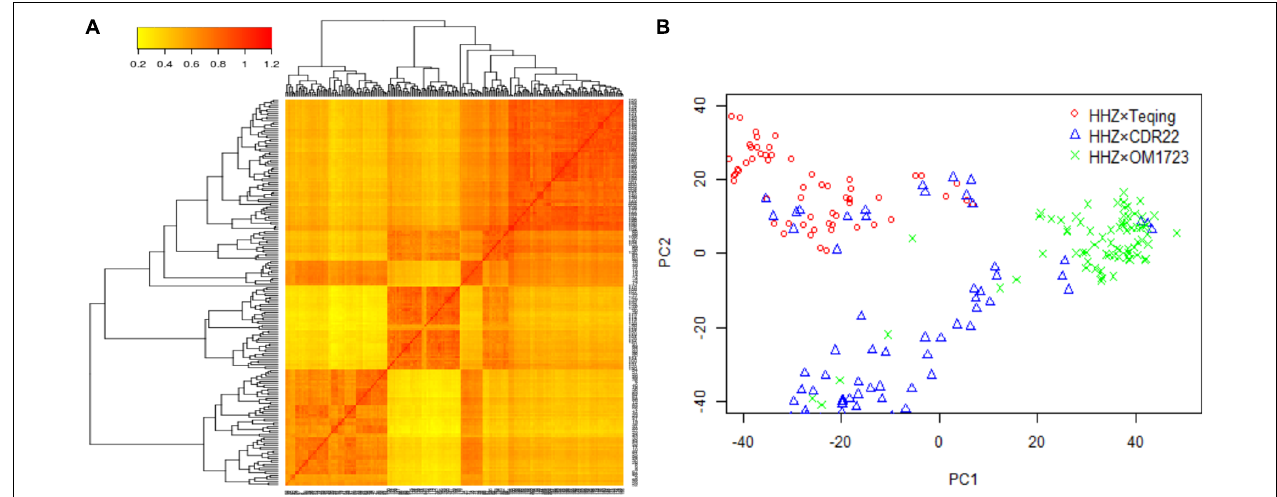
FIGURE 1 | Population structure analysis. (A) Heat map of kinship matrix with the tree shown on the top and left. (B) Plot of the first two principal components in the selected populations.